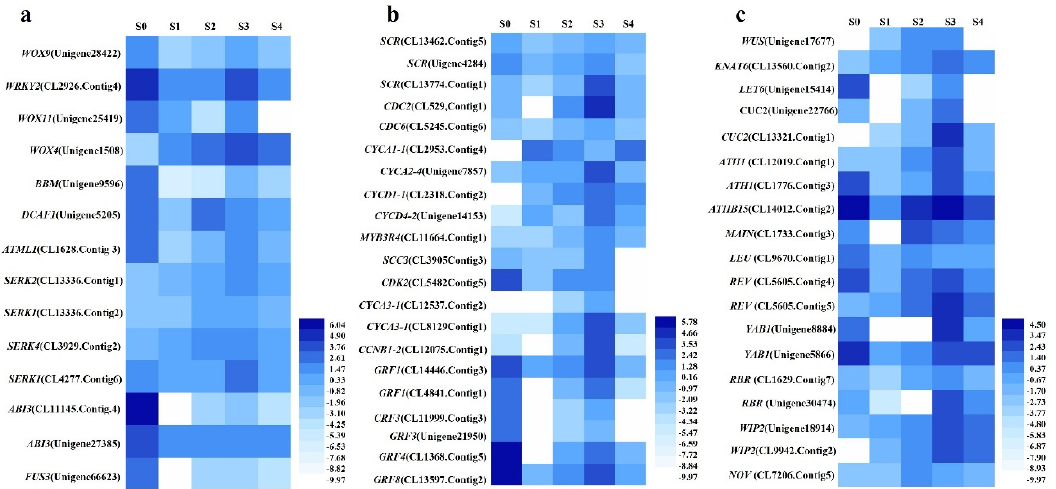
Figure 5. Identification and analysis of the DEGs annotated to somatic embryogenesis. ( a ) Putative decisive DEGs annotated to SE. ( b ) Important DEGs involved in cell division and expansion. ( c ) DEGs related with cell fate specification and shoot apical meristem (SAM) construction.